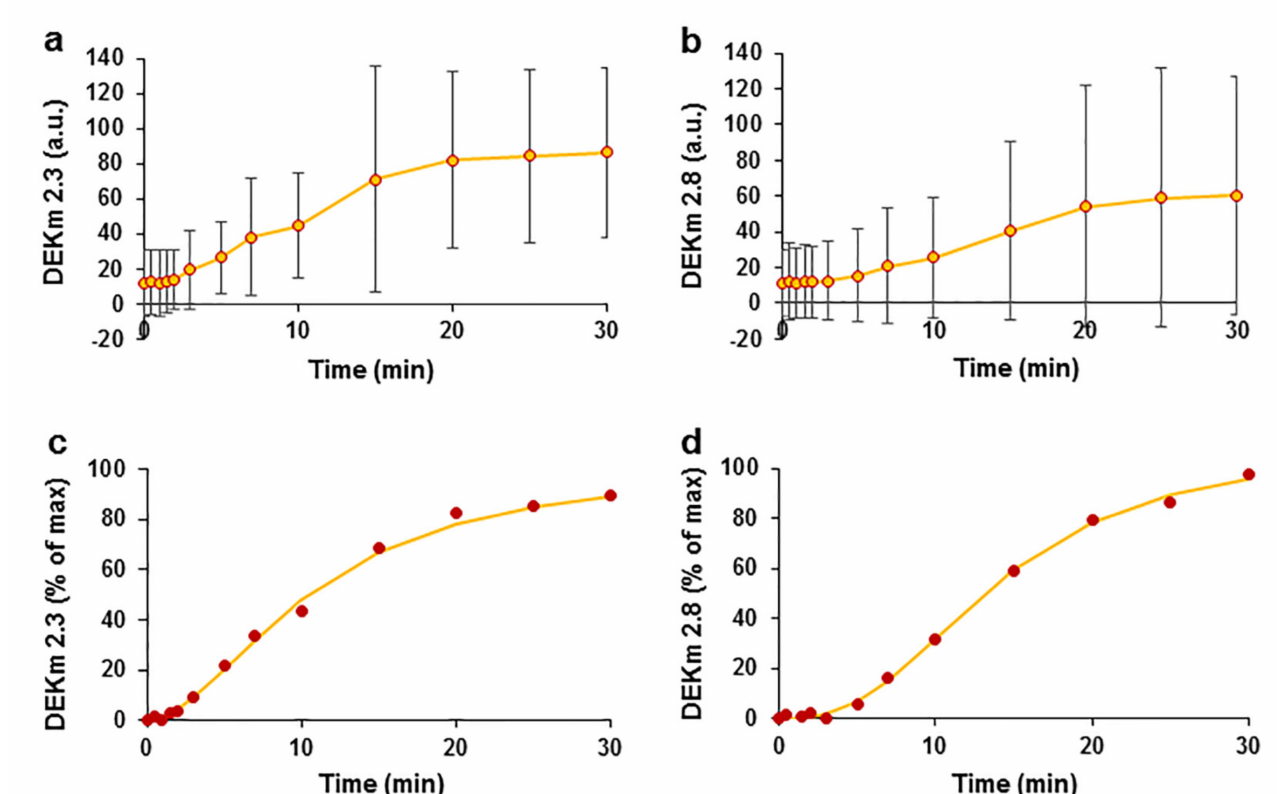
Figure 6. Kinetics of E. ciliata DEK metabolite after an intravenous administration of the EO bolus in swine. Kinetics of the DEK metabolites with RTs of 2.3 min ( a ) and 2.8 min ( b ), (circles) experimental data points reported in a.u. Kinetics of DEK metabolites at RTs of 2.3 min ( c ) and 2.8 min ( d ), normalized and average data were fitted using the Hill time response function (lines). n =